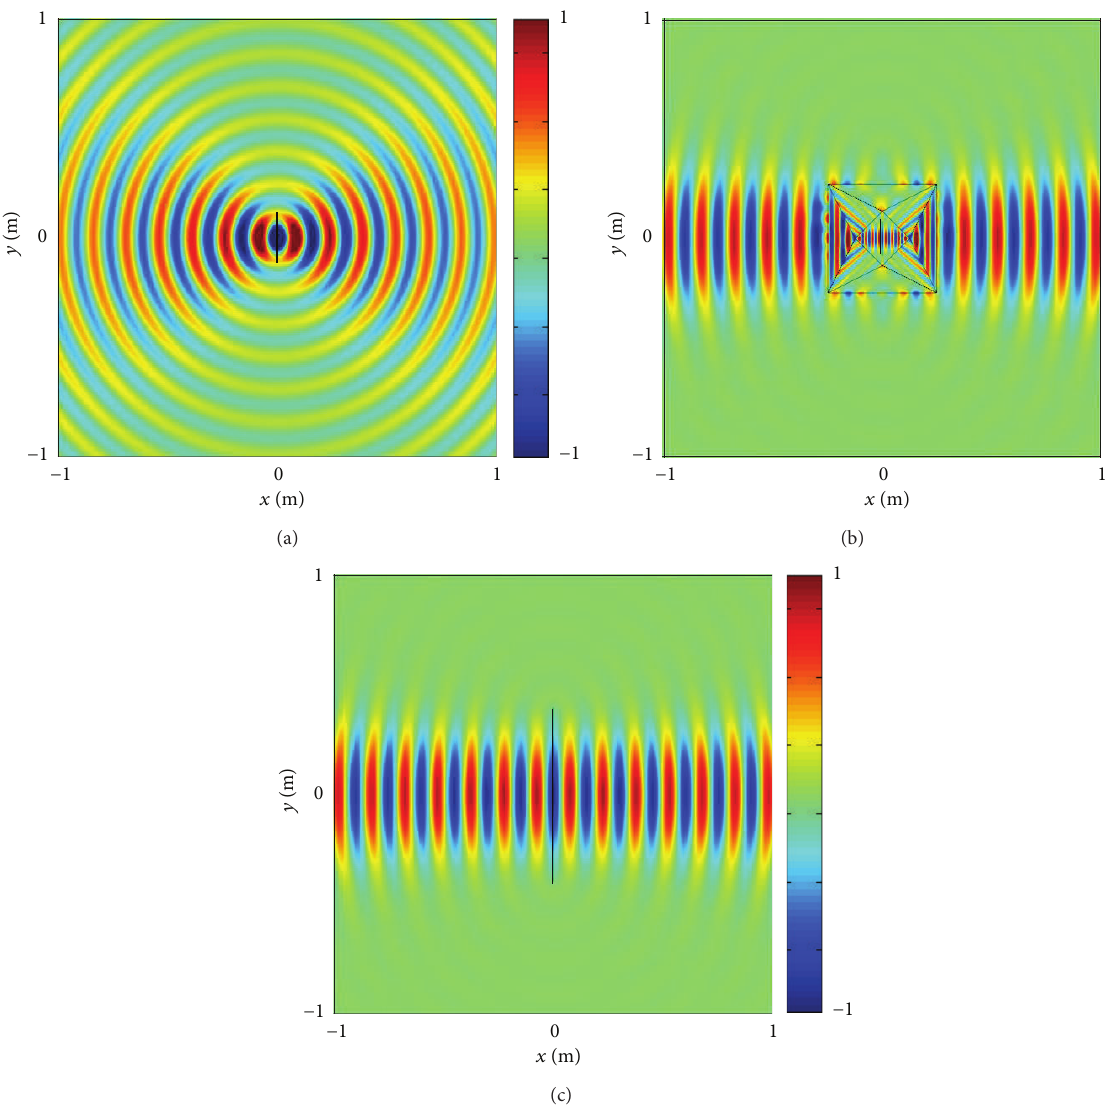
Figure 2: The z -directed electrical field distribution when a naked small current plane with width 𝑤 = 0.16 m is located in (a) free space and (b) square metamaterial substrates, respectively. (c) 𝐸 𝑧 field distribution while a large current plane with the width 0.8 m is radiating in free